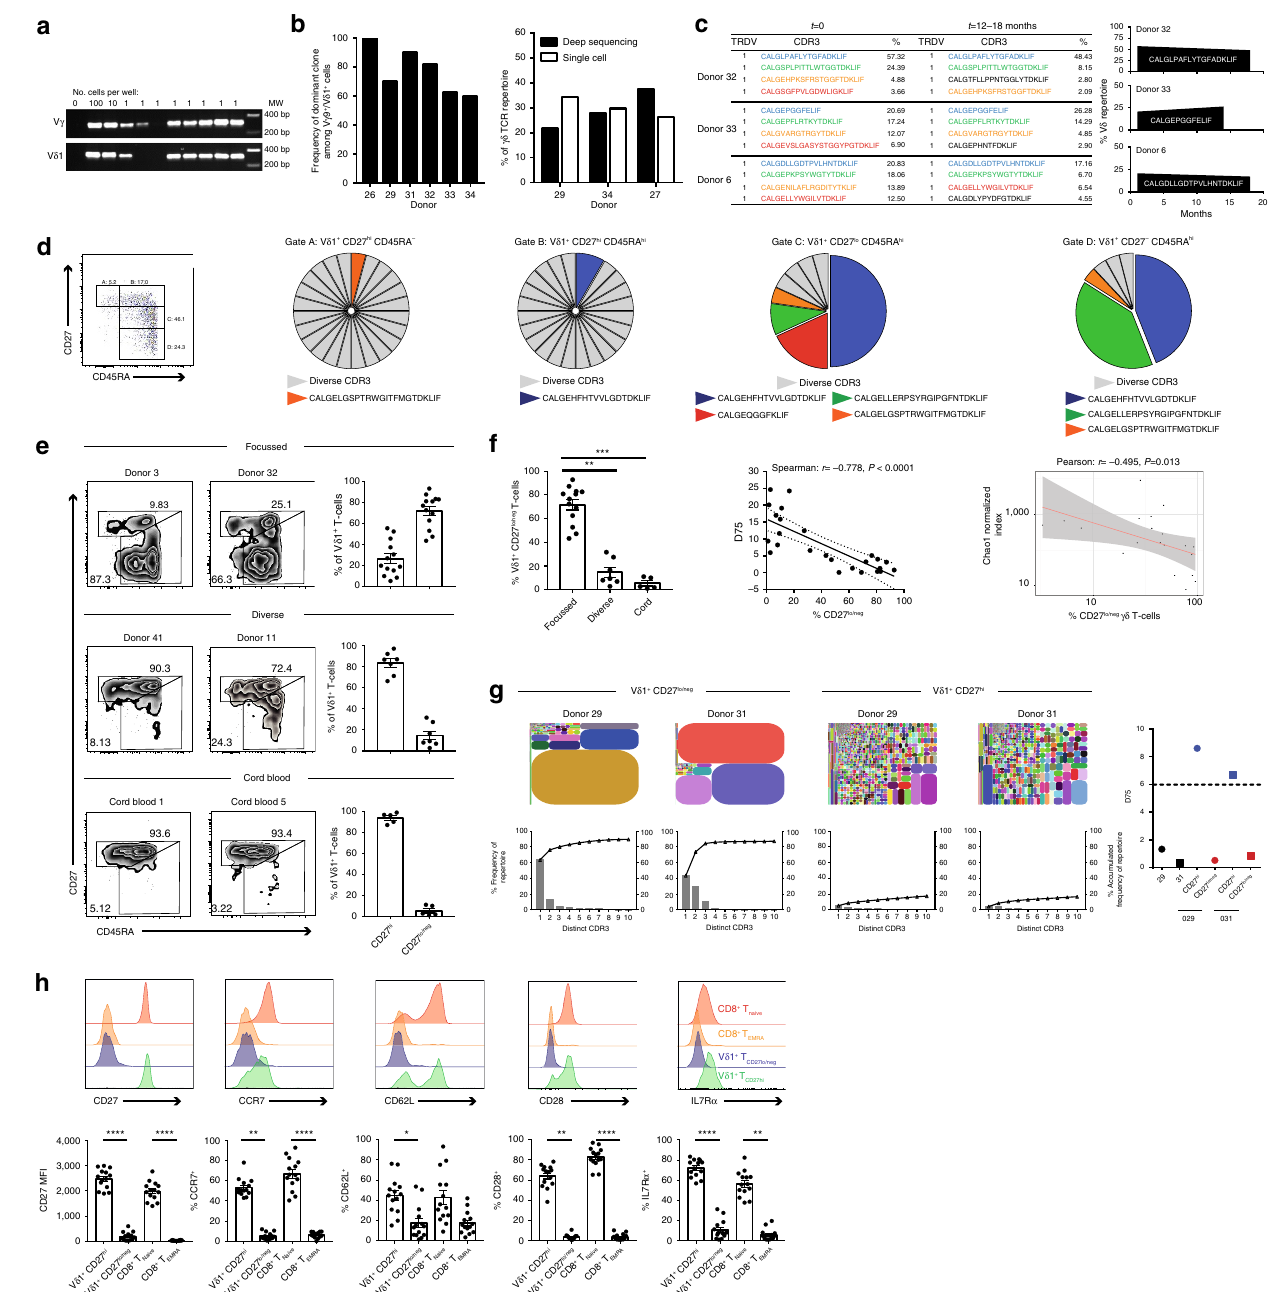
Figure 5 | V d 1 clonal expansion and differentiation is associated with decreased CD27 expression. ( a ) PCR detection of V g 9 and V d 1 TCR chains in single cell sorted V g 9V d 1 T cells. n ¼ 6. ( b ) Frequency of each individual’s dominant clone among single cell sorted V g 9V d 1 T cells. ( c ) Sequential TCR repertoire analyses in three individuals using RACE-PCR (left panel, first time point), and deep-sequencing ARM-PCR (middle panel, second time point, 12–18 months later). Clonotypic sequences are coloured consistently. The right panel depicts the frequency of the top clone within the repertoire over the two time points. ( d ) Relationship between CD27 and CD45RA expression and clonality by single cell PCR analysis of CDR3 d . Each colour represents an individual CDR3 d , with clonal sequences labelled below each chart (from 24 single cells per-population). Data are from one donor, representative of 3. ( e ) V d 1 þ T cells were segregated into CD27 hi and CD27 lo/neg , informed by TCR sequence clonality in d , and this FACS-gating strategy was applied to focused adults (top row, n ¼ 13), unfocused diverse adults (second row, n ¼ 7), and cord blood (third row, n ¼ 4). Flow cytometry data is shown for representative donors, with all donors shown with mean ± s.e.m. (right column). ( f ) Comparison of V d 1 þ CD27 lo/neg cells from all adult and cord blood donors (left panel), correlation with CDR3 d D75 (middle) and Chao1 TCR d 1 diversity metric, normalized to 50,000 randomly chosen CDR3 sequencing reads, (right) for each donor. ( g ) TCR d repertoire analysis of sorted CD27 hi and CD27 lo/neg V d 1 þ T cells, showing Tree maps (top row), accumulated frequency graphs of the top 10 clonotypes (bottom row) and CDR3 d D75 values (right column). ( h ) Comparison of CD27, CCR7, CD62L, CD28 and IL-7R a expression within CD8 þ T EMRA , CD8 þ T naı¨ve , V d 1 þ CD27 hi and V d 1 þ CD27 lo/neg Tcells. Histograms from one representative donor and graphs show mean ± s.e.m. from 14 different donors. Data analysed by Kruskal–Wallis ANOVA with Dunn’s post-test comparisons, * P o 0.05, ** P o 0.01 and **** P o